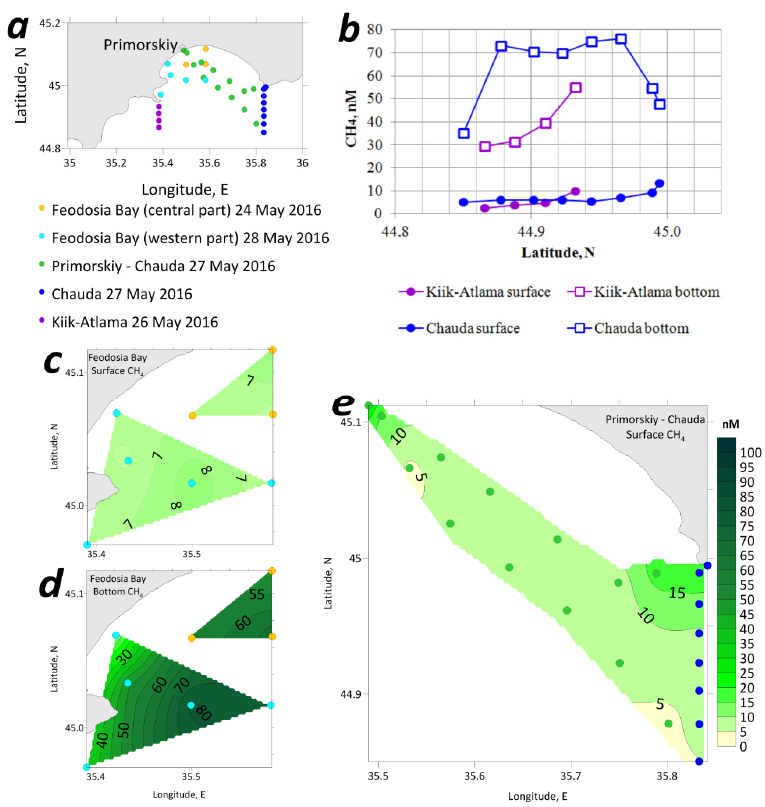
Figure 11. Location of water sampling stations in Feodosia Bay area, May 2016 ( a ). Methane content on sections to the south of the bay ( b ), in the surface ( c ) and bottom ( d ) waters in the western part of the bay and in the surface waters on the Primorsky–Chauda section ( e ).